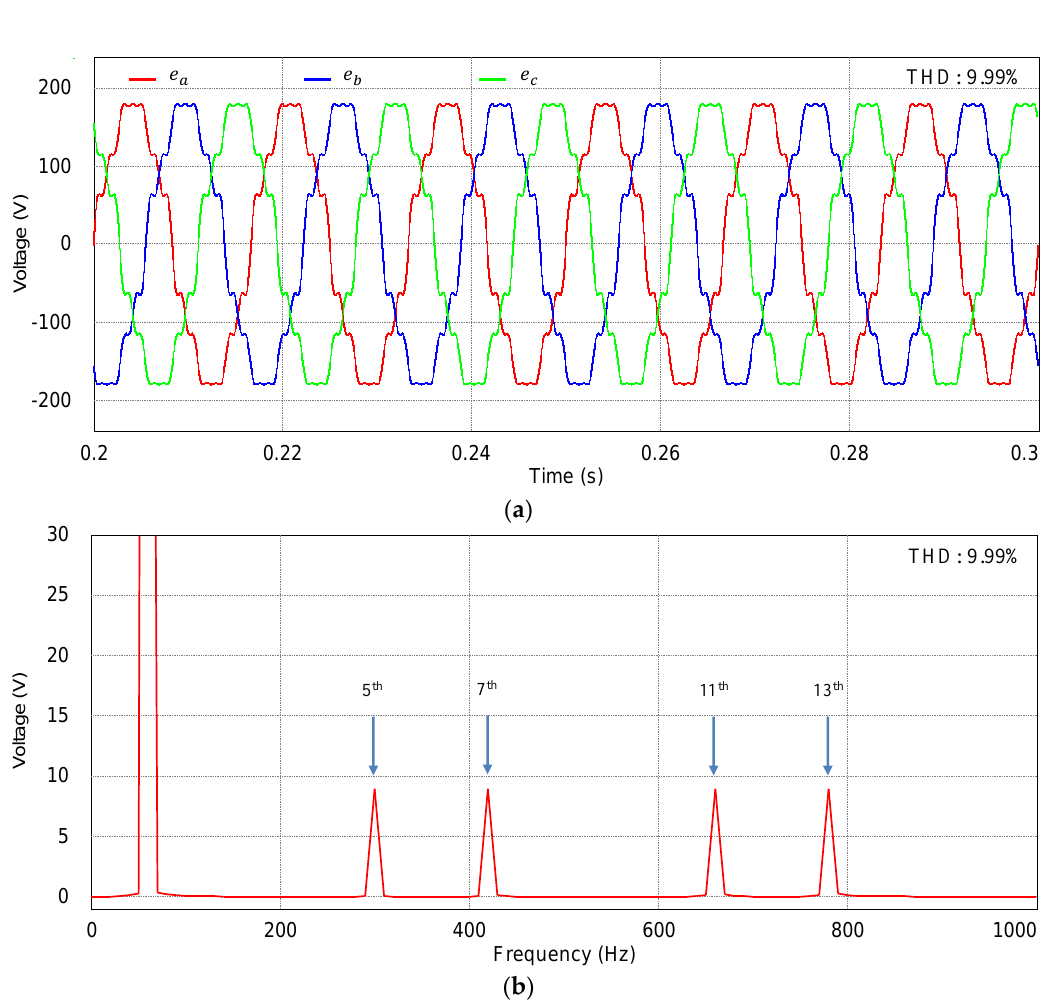
Figure 5. Distorted grid voltages. ( a ) Three-phase distorted grid voltages; ( b ) Fast Fourier transform (FFT) result of a -phase voltage.